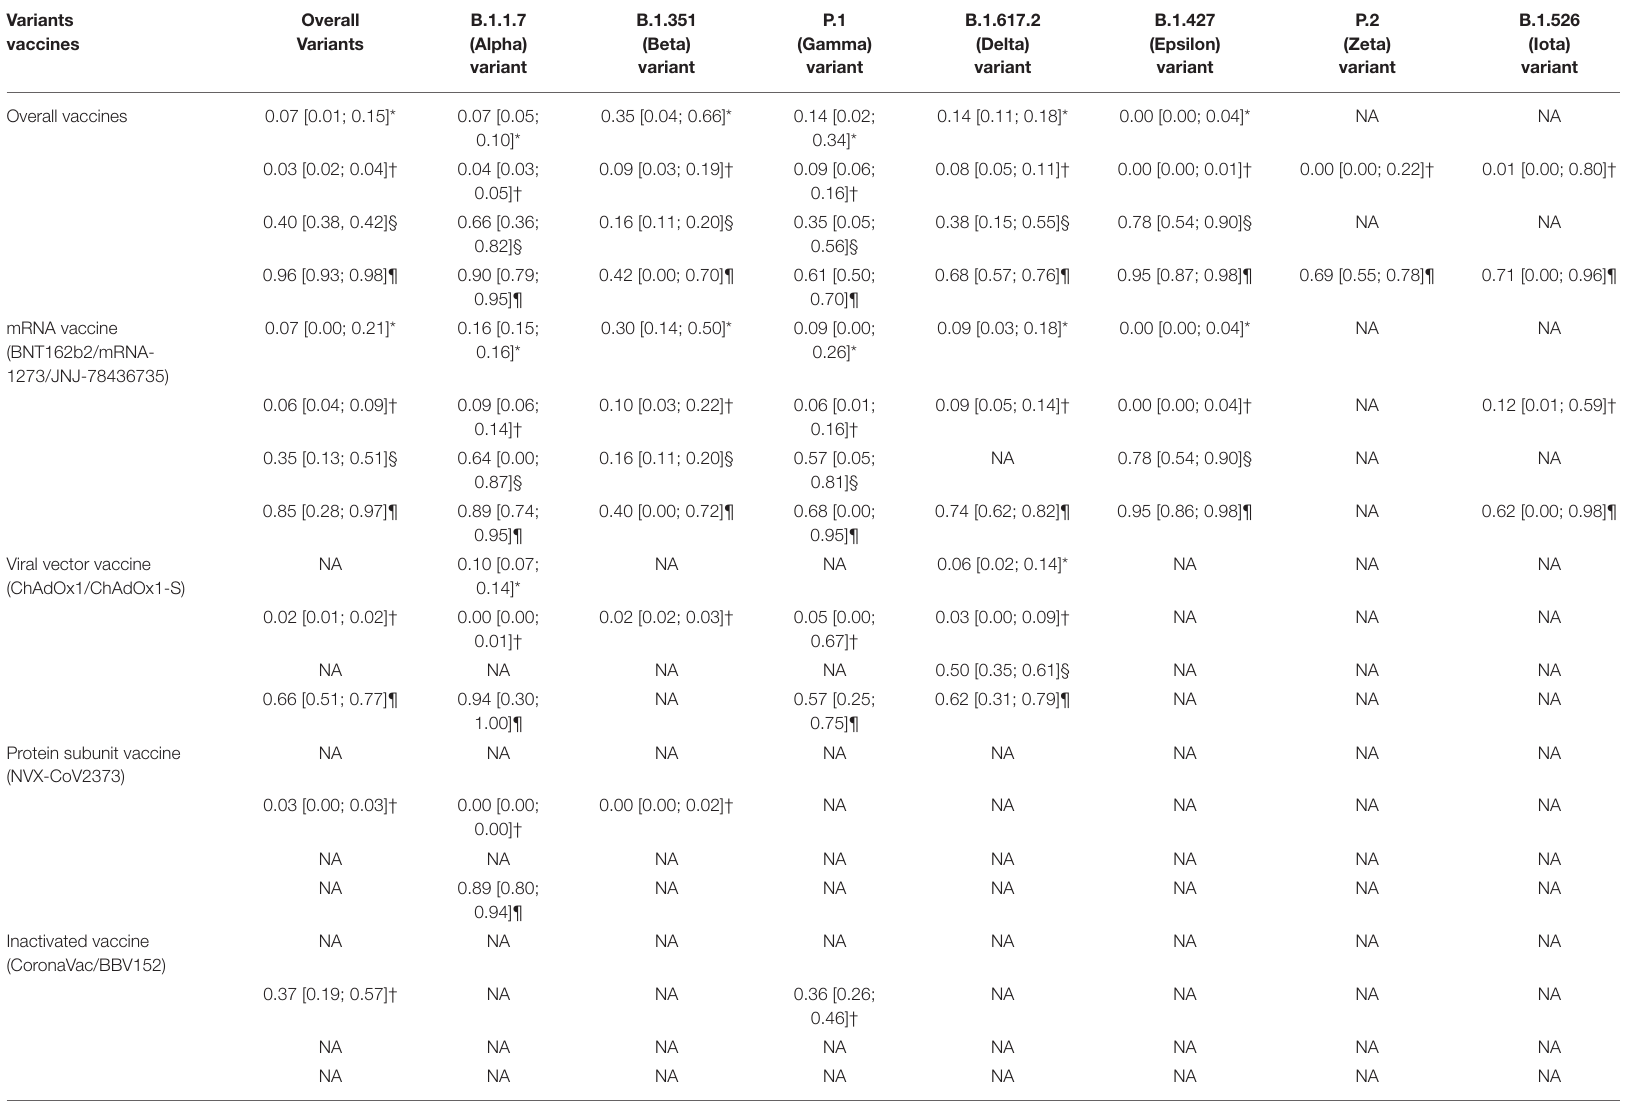
TABLE 2 | Results of the meta-analysis. Variants